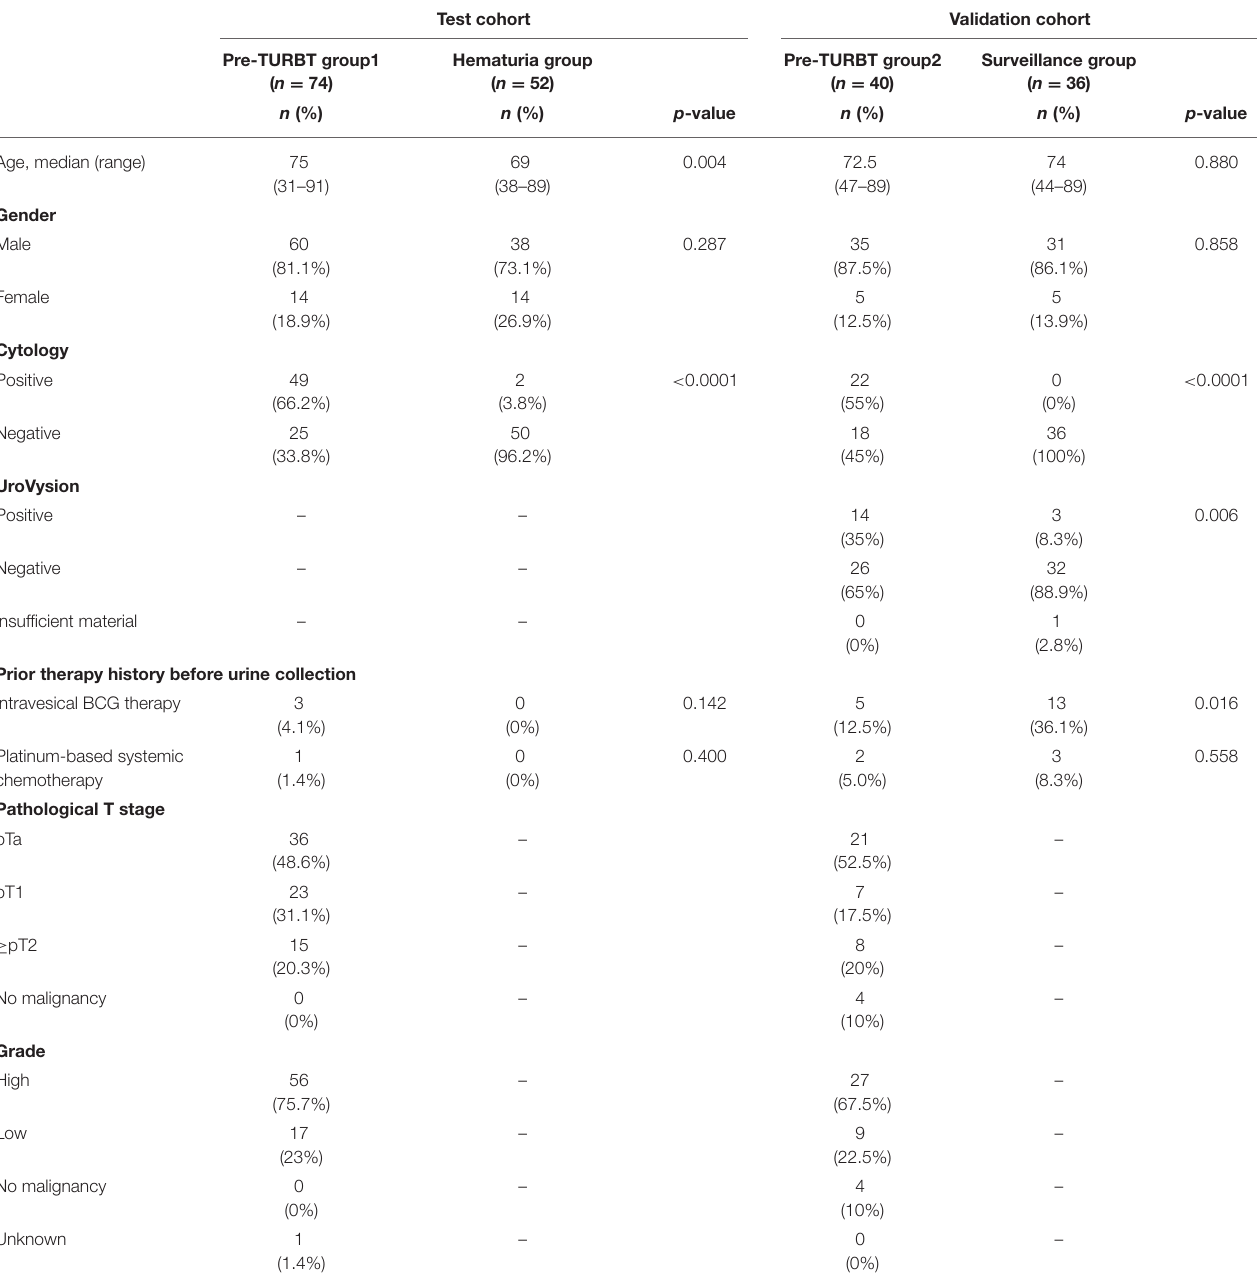
TABLE 1 | Patients characteristics for urinary cell-free DNA